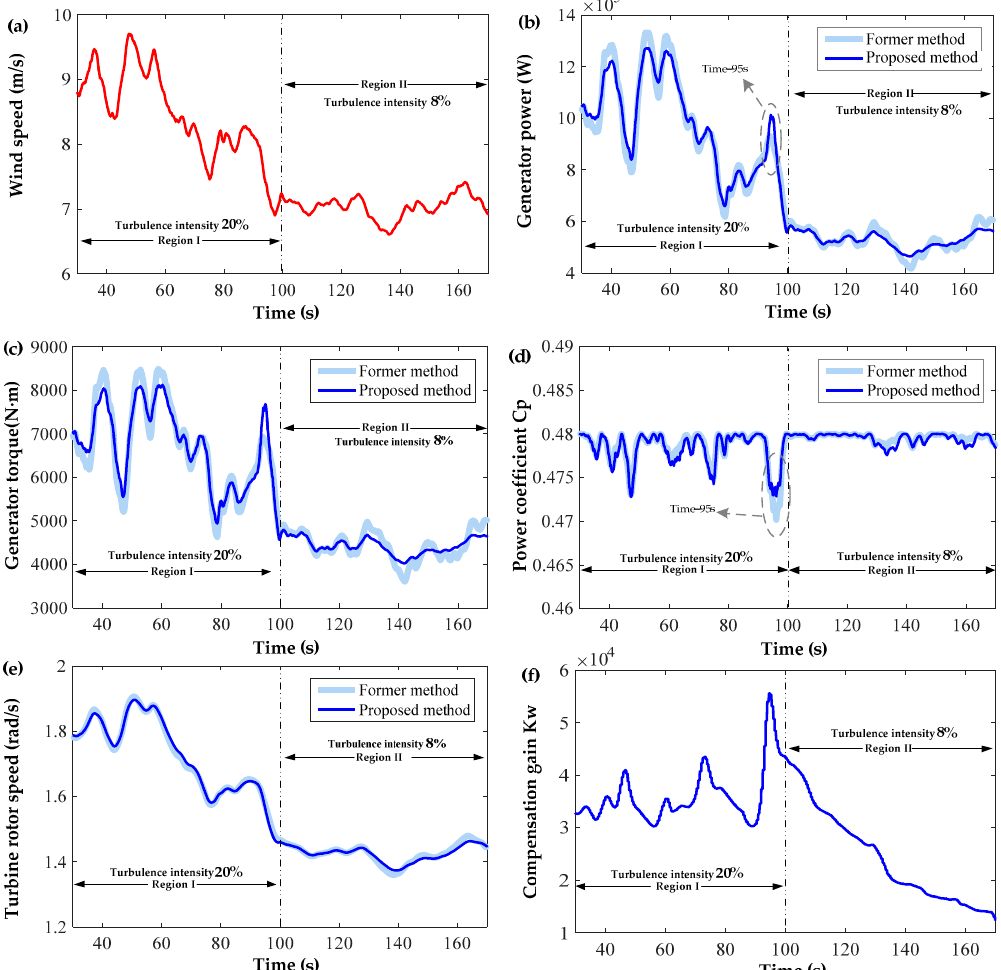
Figure 12. Simulation results under low and high wind fluctuations, ( a ) wind speed; ( b ) generator power; ( c ) generator torque; ( d ) conversion efficiency; ( e ) rotor speed; ( f ) compensation gain.